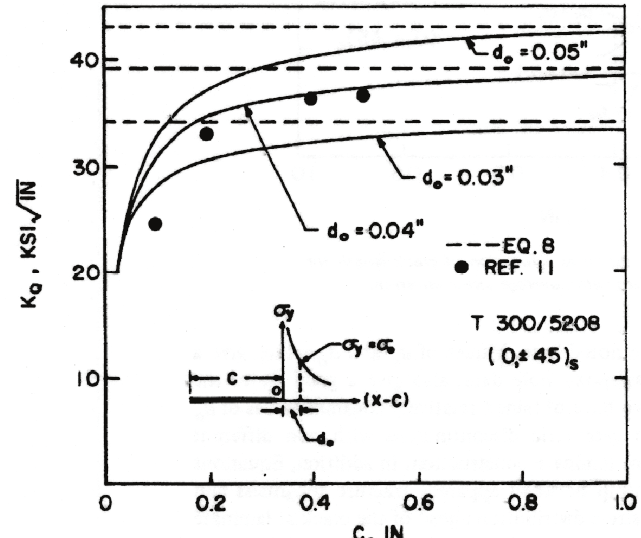
Figure 3: Data from Whitney and Nuismer [3] showing the effect of notch length (c) on fracture toughness, for sharp notches in a graph-epoxy laminate material. Prediction lines using the point method, drawn at different values of the critical distance d o (equivalent to